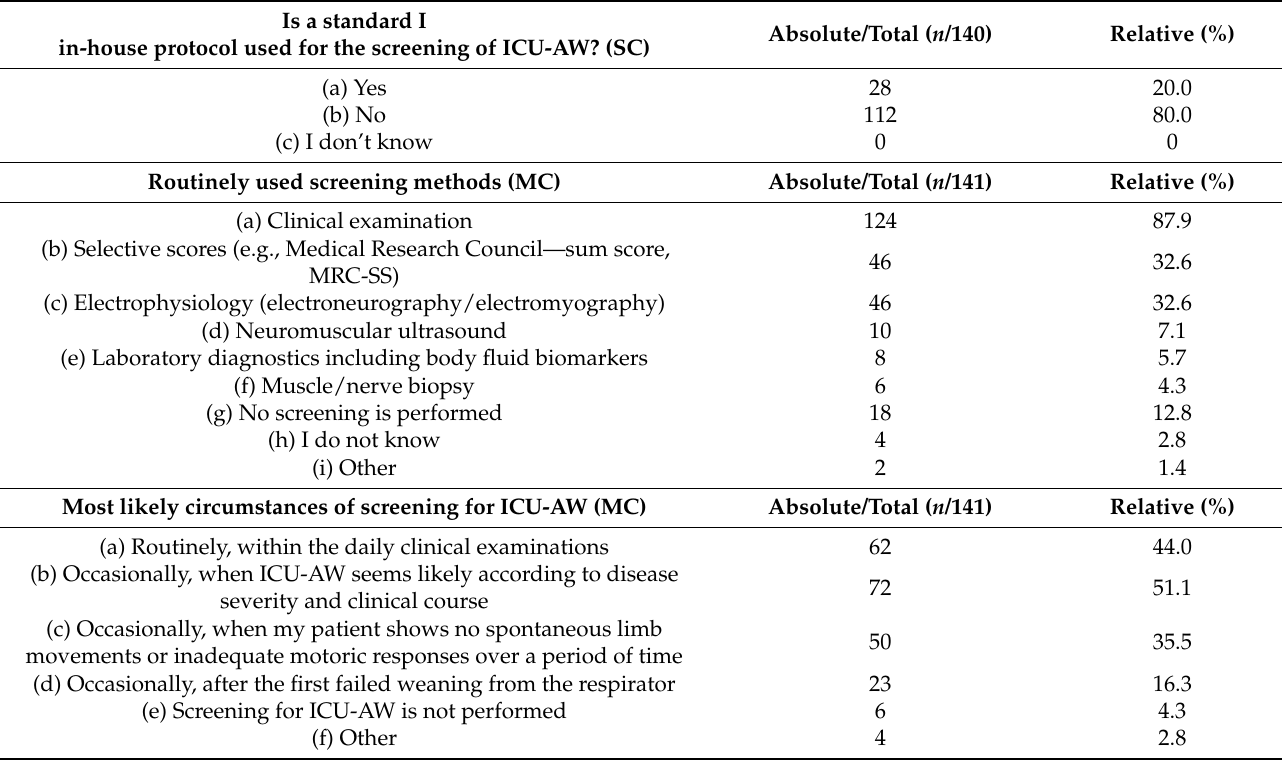
Table 2. Screening, diagnostics and monitoring of ICU-AW. Absolute counts indicate all participants who chose the particular answer of the corresponding question. Total counts indicate all study participants who answered the question at all. Relative counts indicate the ratio of absolute to total counts in